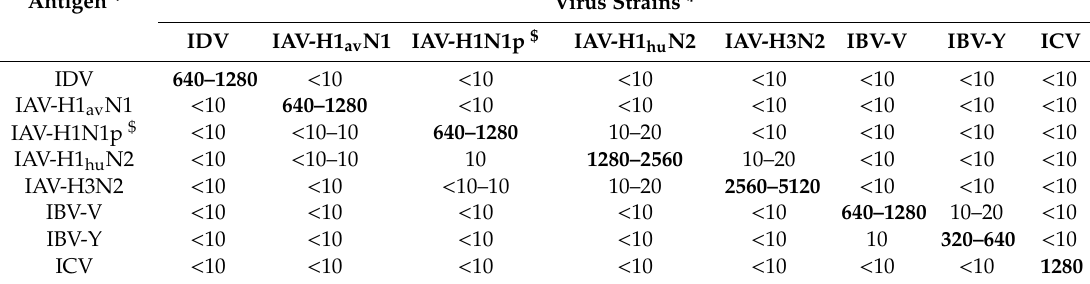
Table 1. Cross-hemagglutination inhibition (HI) assays between hyper-immune sera produced in SPF pigs and reference antigens from D, A, B and C types. Titer ranges were obtained from at least four assays conducted during two independent experiments. Homologous titers are indicated in bold font. Swine Hyperimmune Sera Containing Antibodies Directed against Reference